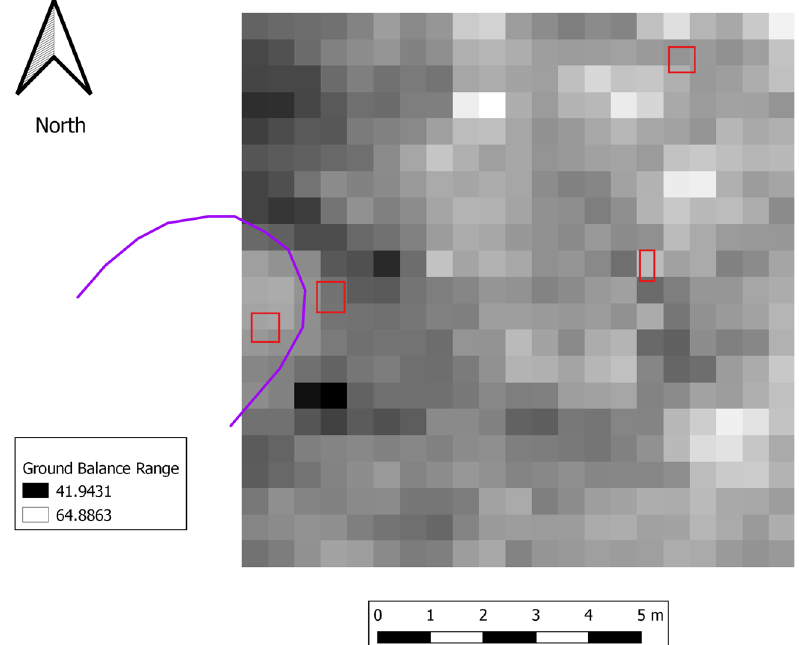
Figure 8: Interpolation map of Round Top B. Culvert location drawn in purple. Shovel test locations in